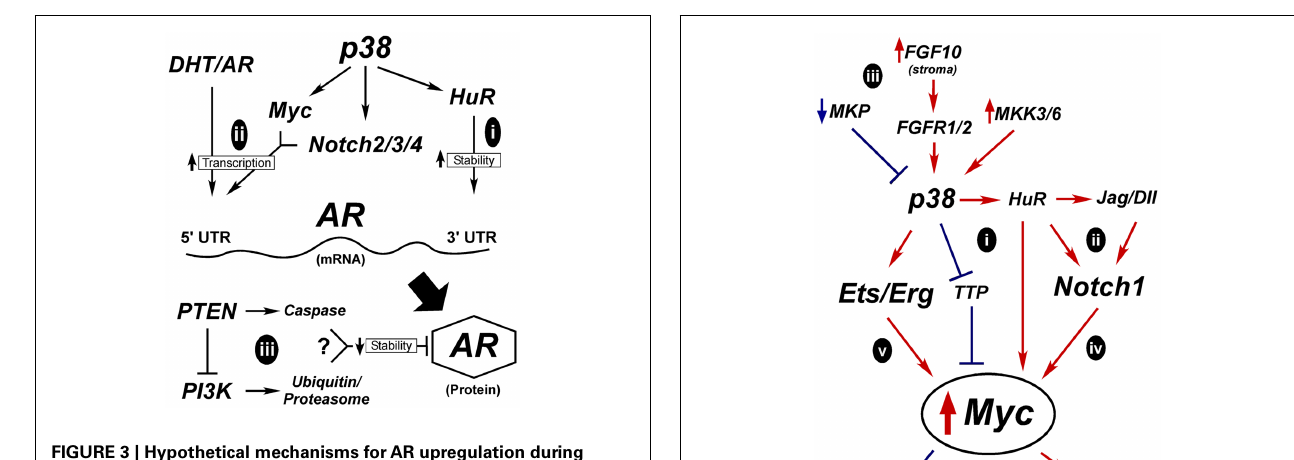
FIGURE 3 | Hypothetical mechanisms forAR upregulation during differentiation . AR expression is tightly controlled both transcriptionally and post-transcriptionally. Early in differentiation prior to stable AR expression, p38 stimulates AR expression most likely by regulating mRNA stability (i) . Once low levels of AR are made, androgen (DHT) binding to AR stimulates its binding to its own promoter through AR binding elements (ARE).This requires the cooperation of signals from p38 that stimulate Myc and Notch2/3/4 to suppress cell adhesion, ultimately elevating AR mRNA transcription (ii) . AR protein is degraded through two different mechanisms (iii) , the classical ubiquitinylation system and through caspase 3. Both Pten and PI3K are reported to influence these degradation pathways; although how these two contradictory signals are balanced is not clear.